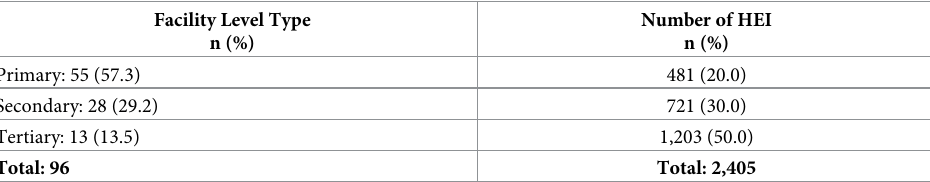
Table 1. Distribution of study participants and facility